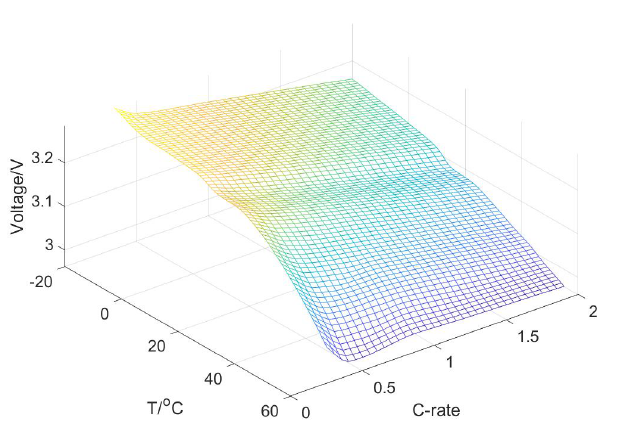
Figure 10. The output voltage of the battery varies with the ambient temperature and C-rate. Table 2. The average output voltage of the battery under 36 discharging conditions.